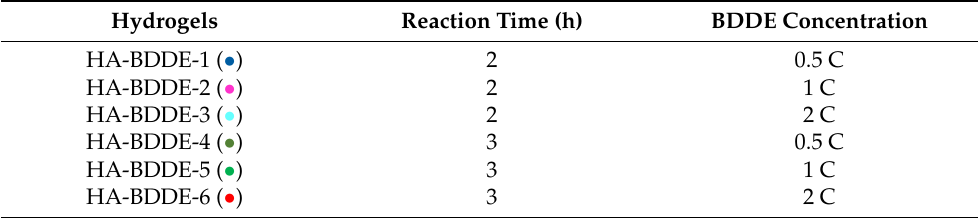
Table 2. Summary of synthesized HA-BDDE samples and their crosslinking